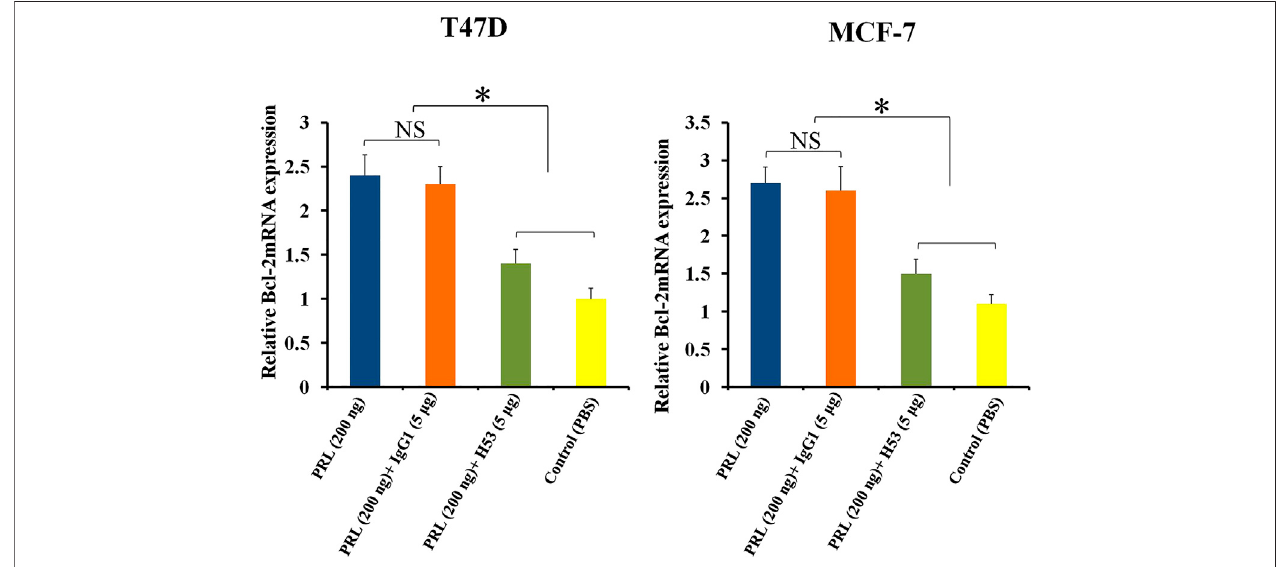
FIGURE 9 | H53 suppressed the expression of Bcl-2 gene. Bcl-2 mRNA level was measured with RT-qPCR assay. T47D and MCF-7 were challenged with PRL (200 ng/ml), the mixture of PRL/H53 or the mixture of PRL/IgG1. Asterisk (*) represents a statistically signi fi cant ( p < 0.05).